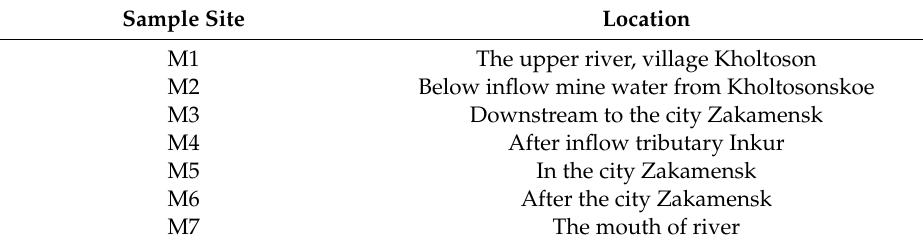
Table 1. Sampling site and their location along r.